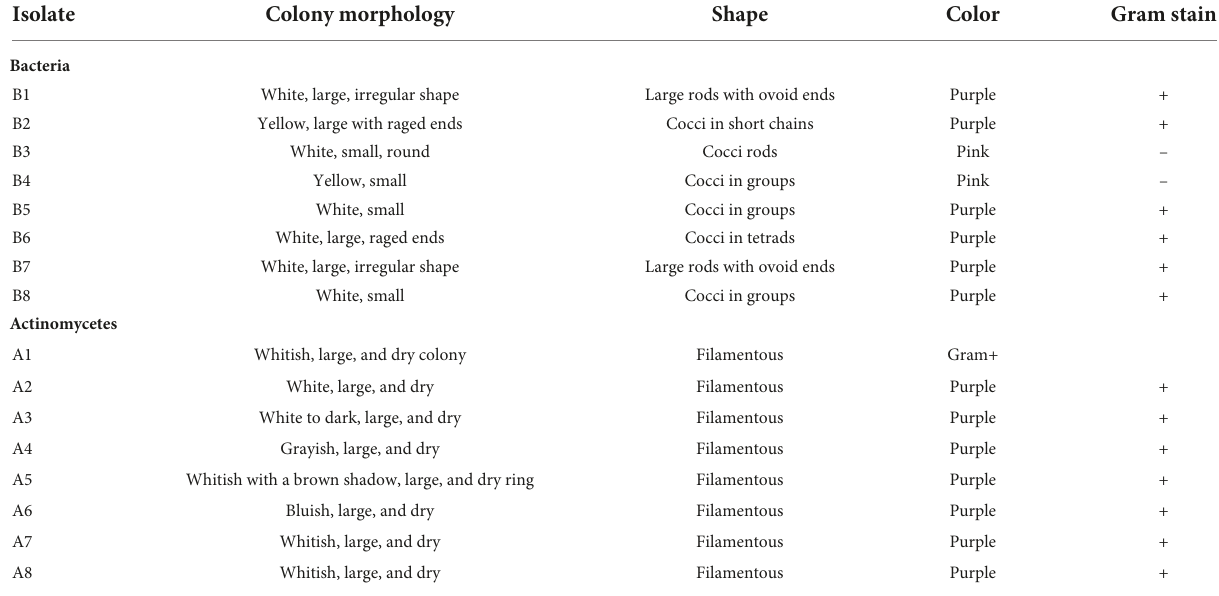
TABLE 5 Morphology of plastics-degrading fungi. Isolate